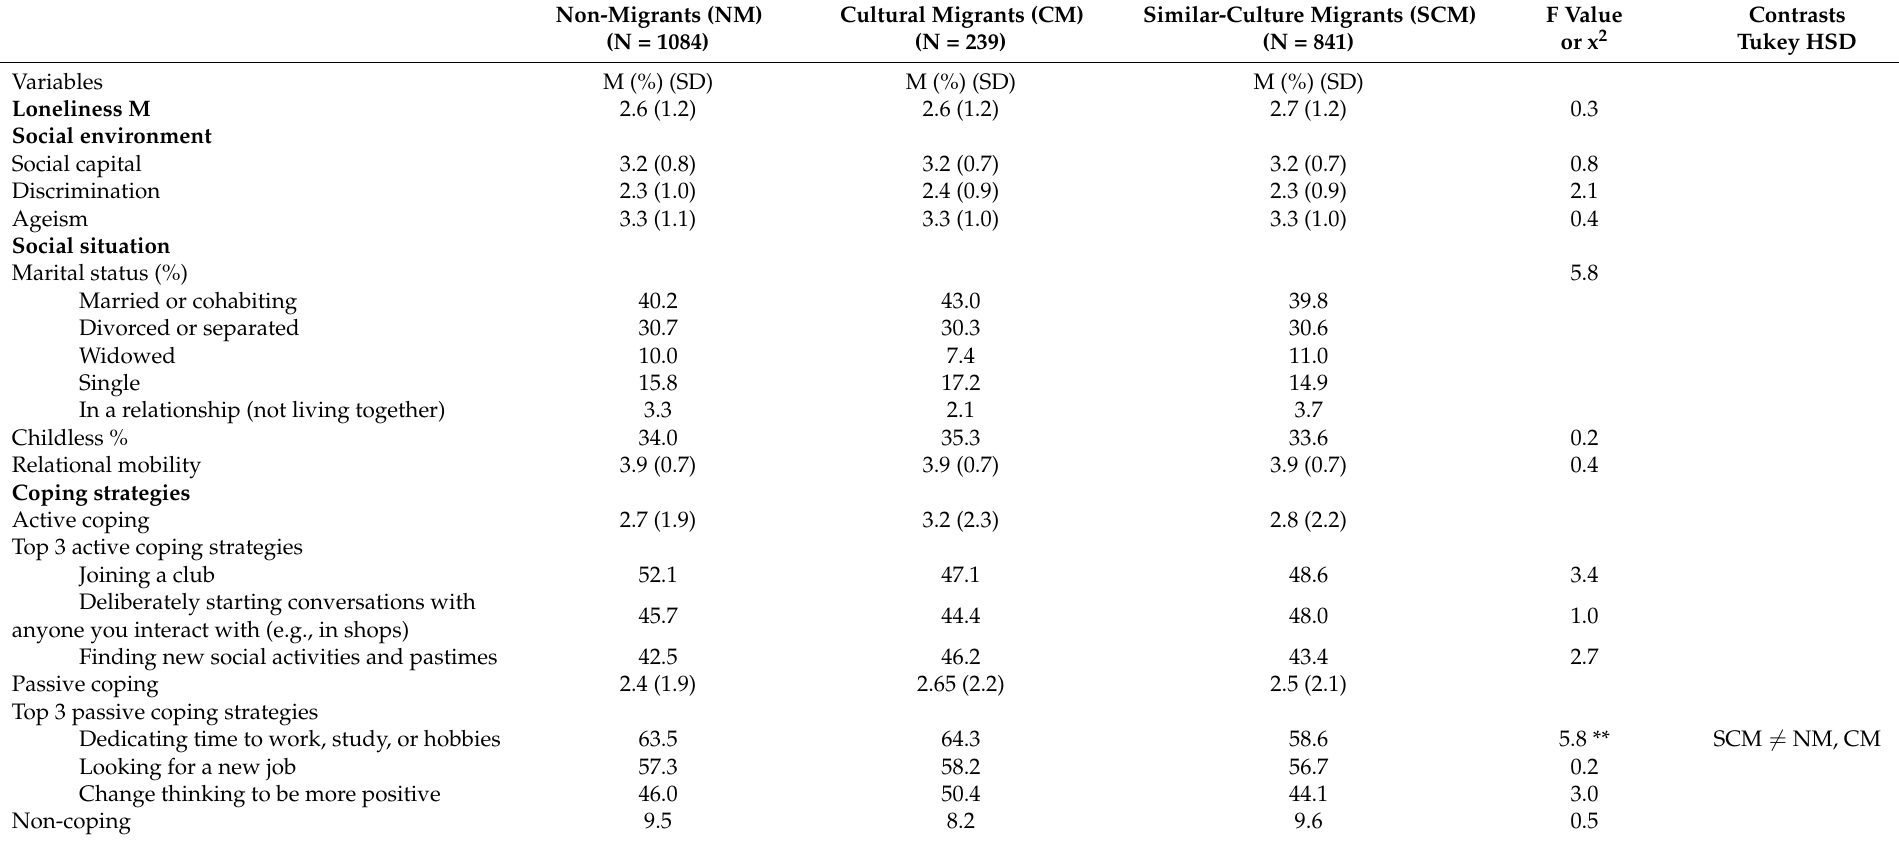
Table 1. Sample descriptive